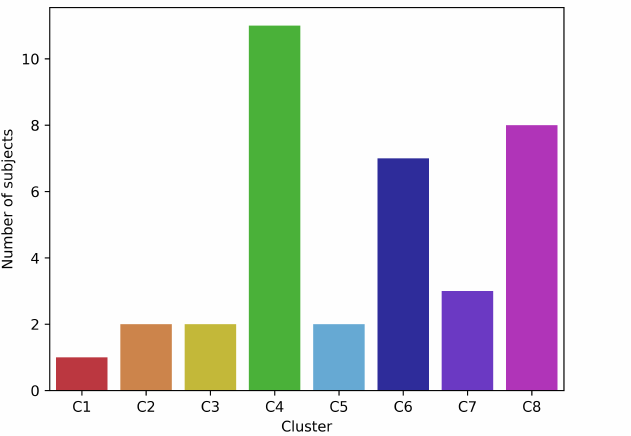
Figure 10. Inter-level variation clusters, along with the number of included subjects A deeper analysis of the most populated clusters is reported below; for the sake of clarity, an inter-level EI decrease (increase) is represented as D (I),